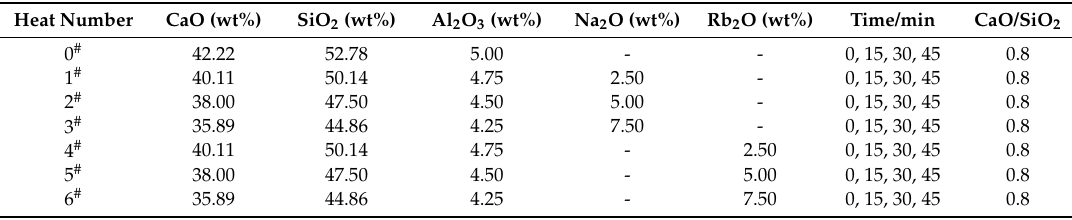
Table 1. Chemical composition of synthesized refining slag.